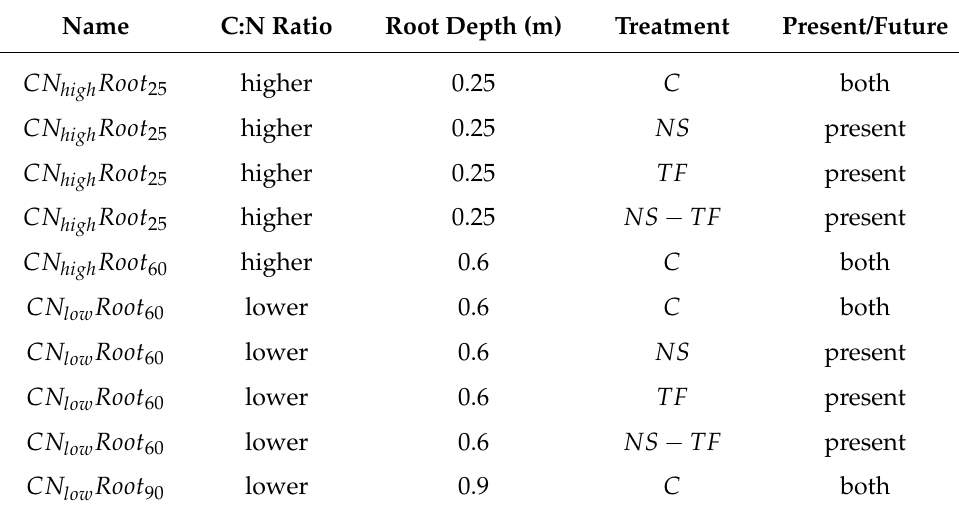
Table 2. Table of simulations discussed in this paper. C represents the control simulation, NS represents fertiliser added near the surface; TF represents fertiliser added near the thaw-front; and NS − TF represents fertiliser added both near the surface and deeper in the